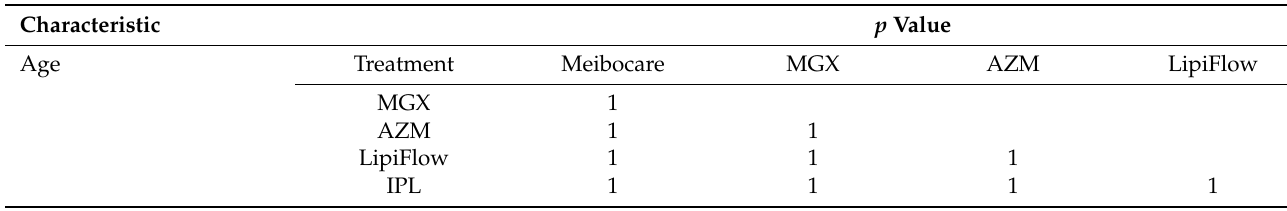
Table 2. Comparison of the baseline characteristics of the study subjects with meibomian gland dysfunction in the